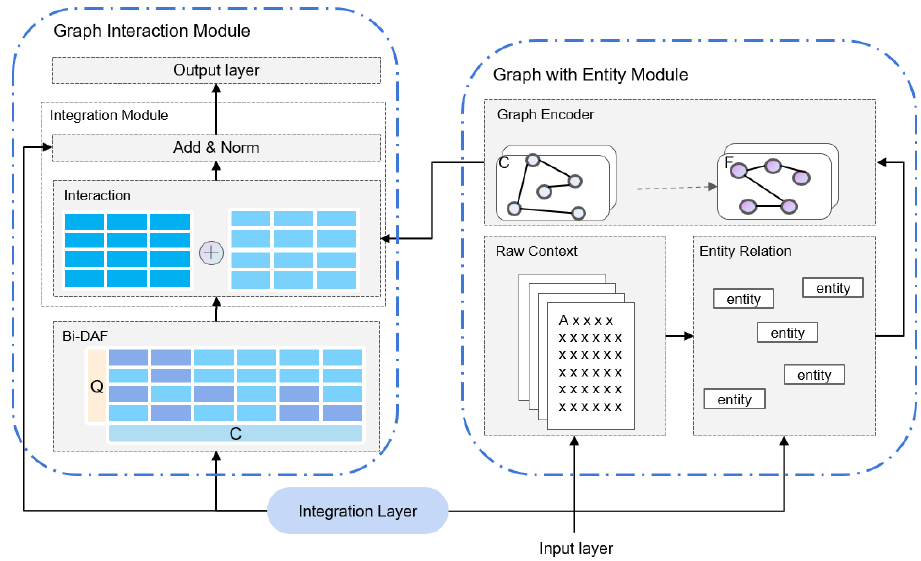
Figure 5. An overall architecture of the feature interaction module. On the right side of the figure, the GE module extracts named entities and builds a graph network based on specific relationships. Combining Bi-DAF (left side of the figure) with the output of GE for the segment prediction task.